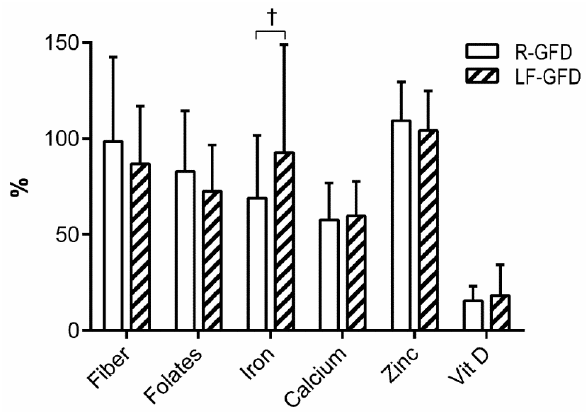
Figure 1. Adequacy level of critical nutrients between groups against the dietary recommendations. Data as mean ± SD. † Adequacy: [nutrient intake/nutrient daily recommendation (RDA)] × 100. Independent samples t -test: † p = 0.081. R-GFD: Regular gluten-free diet, LF-GFD: Low-FODMAP gluten-free diet.